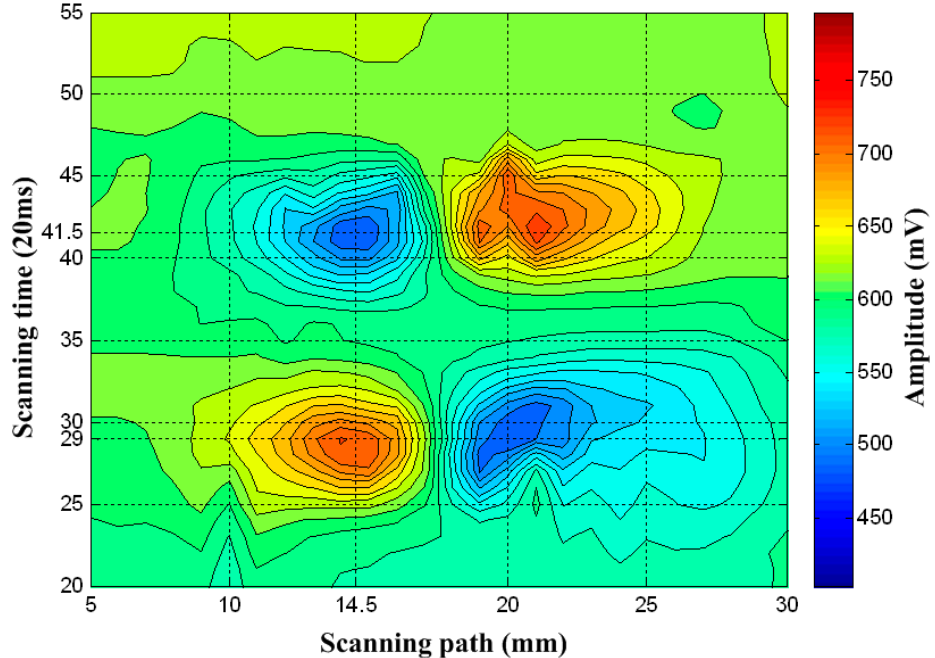
Figure 10. C-scan outline images of defect 3 in the direction of magnetic flux.